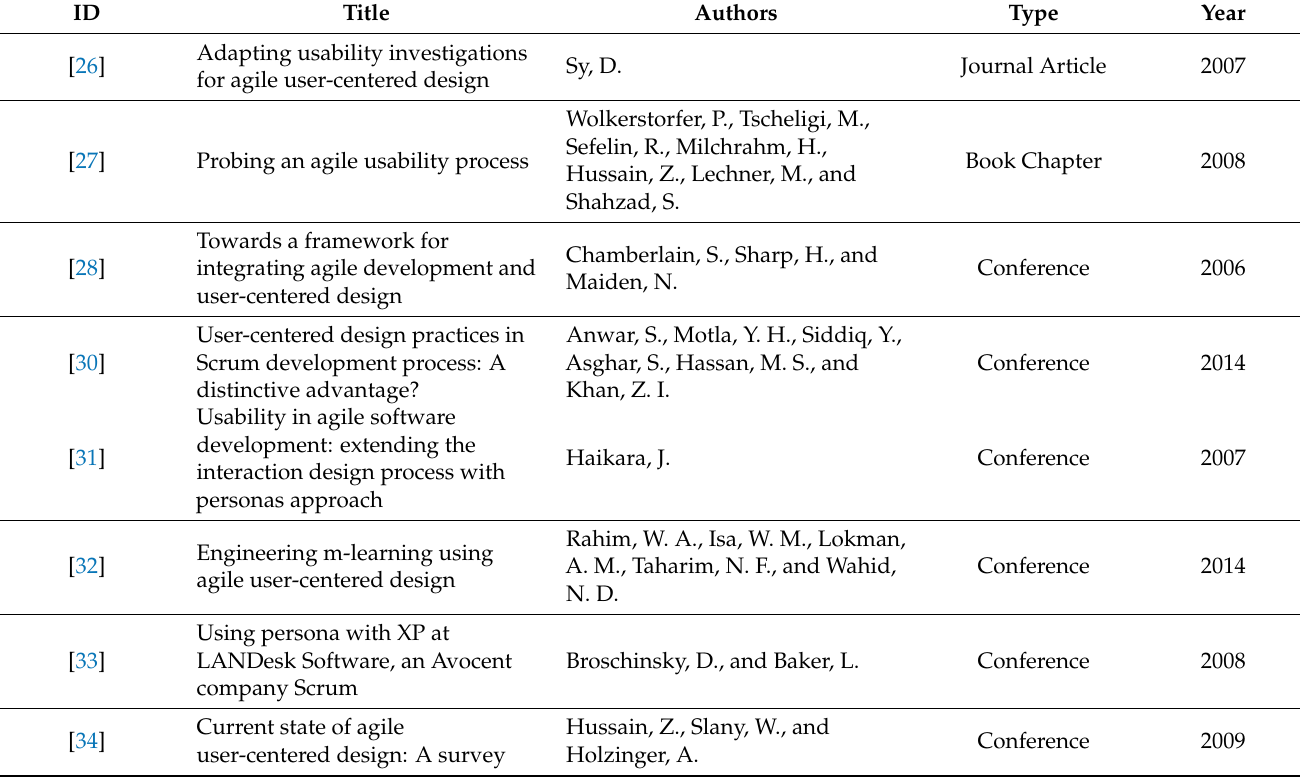
Table A1. Control group